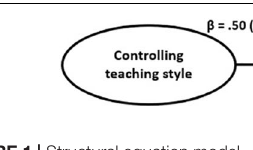
FIGURE 1 | Structural equation